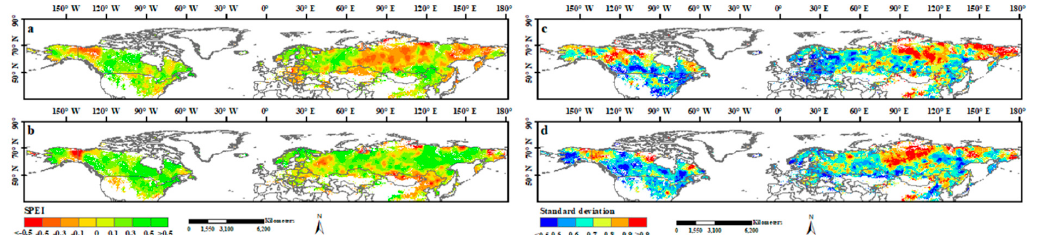
Figure 4. Spatial patterns of SPEI and its standard deviation during 1982–1998 and 1999–2015. ( a , b ) the spatial patterns of SPEI during 1982–1998 and 1999–2015, respectively; ( c , d ) the spatial patterns of standard deviation of SPEI during 1982–1998 and 1999–2015, with low standard deviations were widely concentrated in the middle- and low-latitude regions (Figure 4c,d).